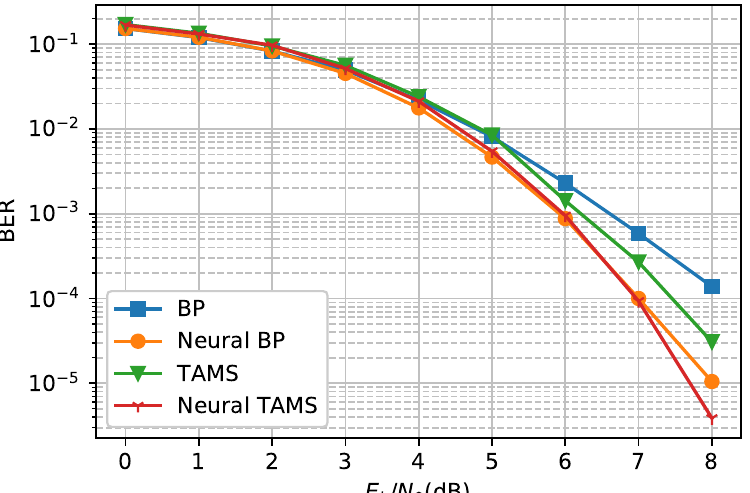
Figure 6. Performance comparison between BP and TAMS algorithms and their neural network versions for the (47, 24) QR code. All decoders applied 5 BP/min-sum iterations.